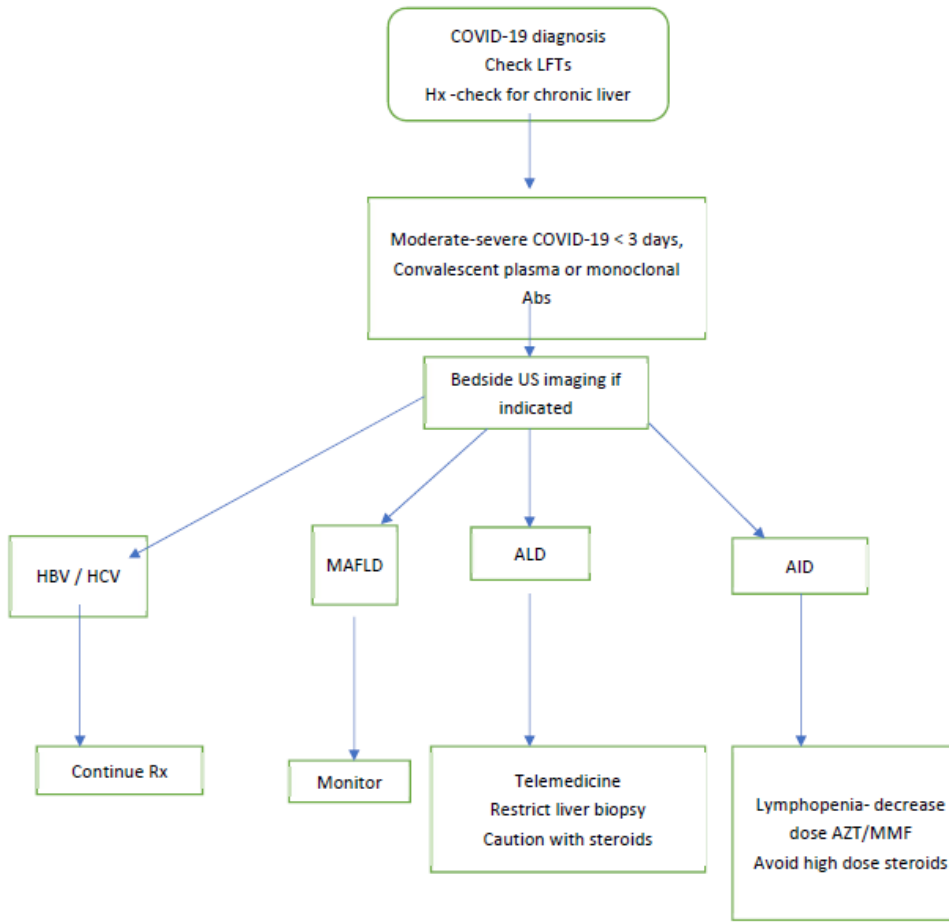
Figure 5. Proposed clinical therapy and monitoring of patients during hospitalization. Proposed clinical therapy and monitoring of patients during hospitalization.